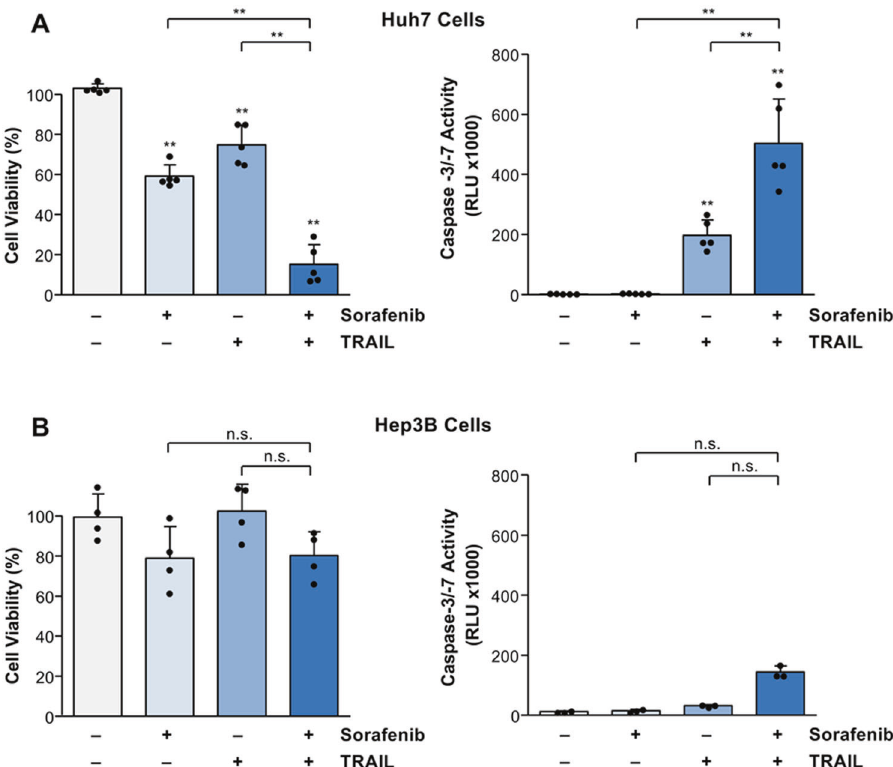
shown. P -values above the bars refer to control. ** p < 0.01; n.s. non-signi fi